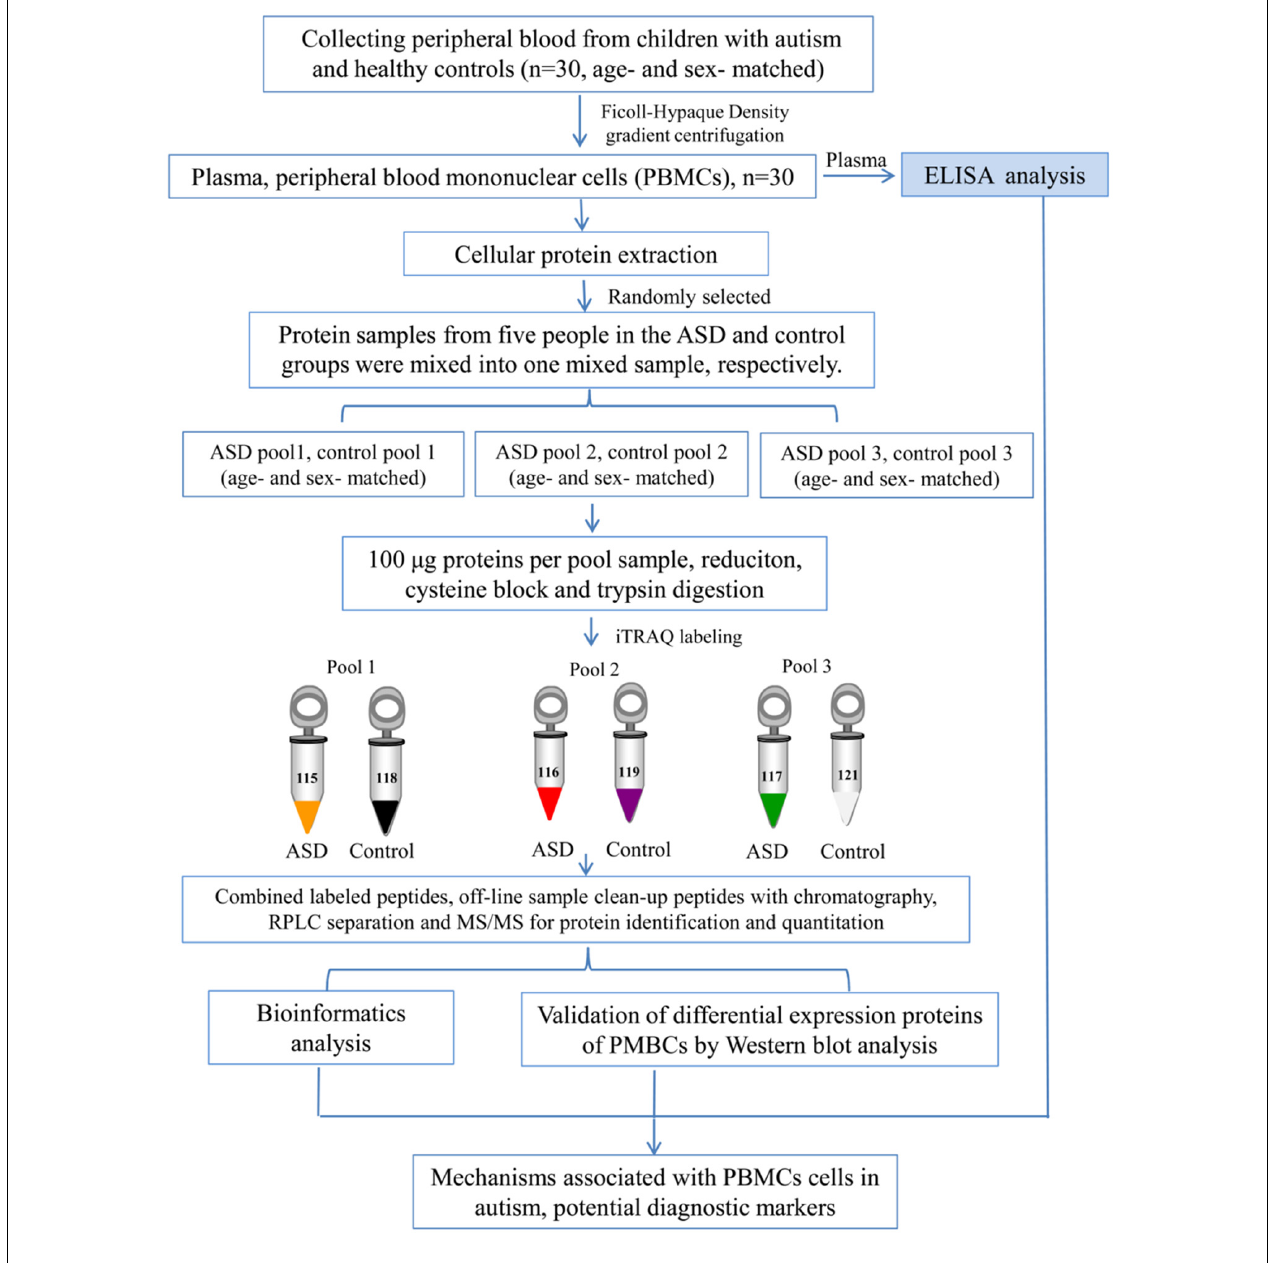
FIGURE 1 | Workflow used in this